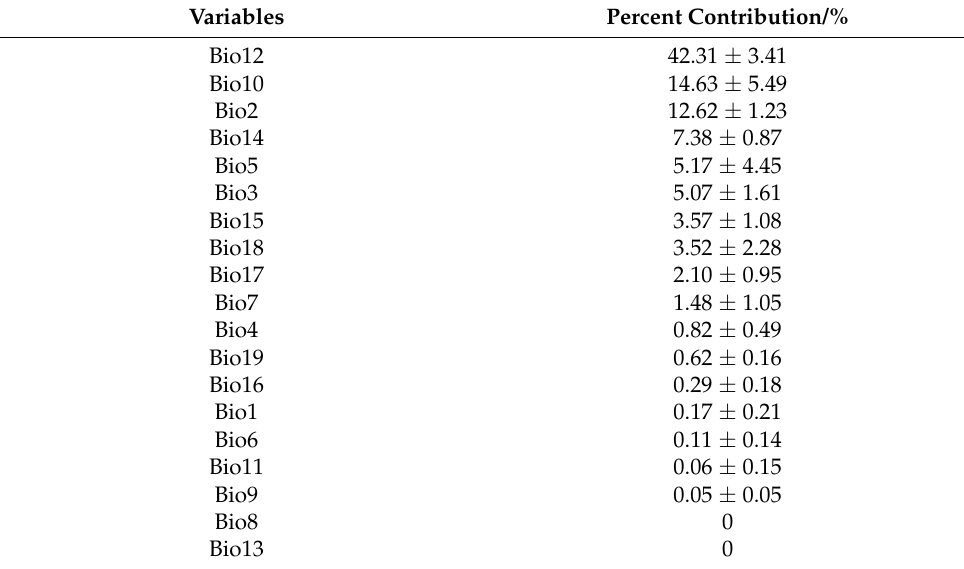
Figure 2. The receiver operating characteristic curve predicting the current potential distribution of Carex alatauensis based on the MaxEnt model. Table 2. Contribution rate of each climatic factor for the distribution of Carex alatauensis